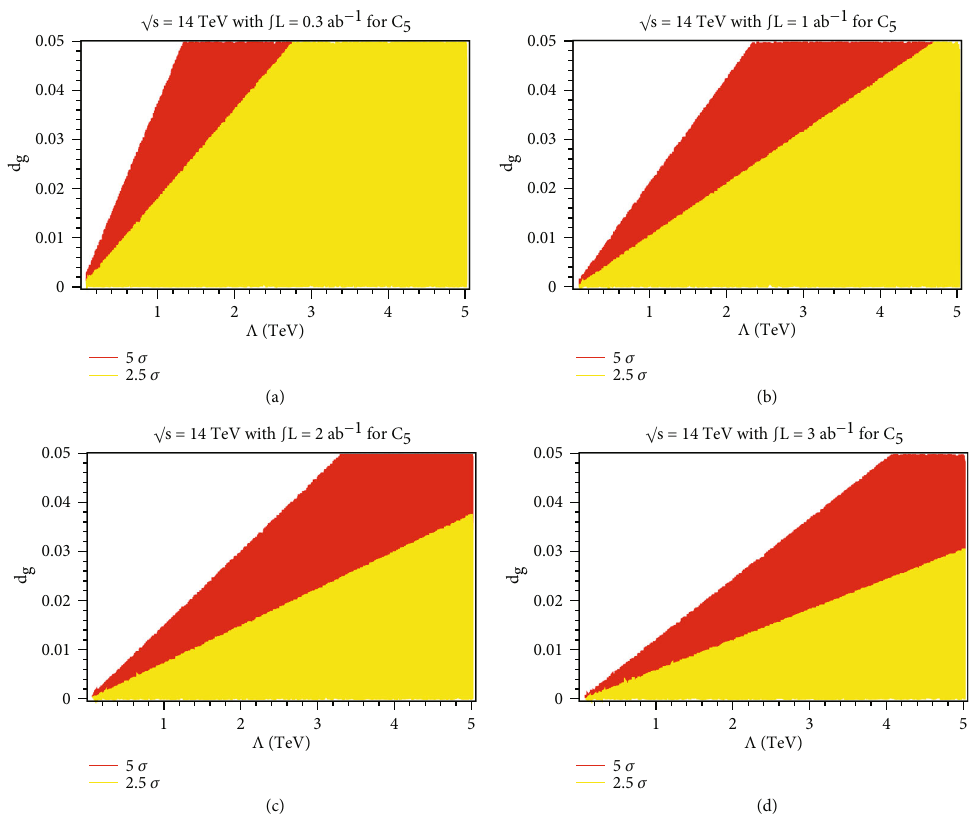
ffiffiffi p at = 14TeV energy at LHC for an integrated luminosity of (a) 0 : 3 ab − 1 , (b) 1 ab − 1 , (c) 2 ab − 1 , and (d) S 5 ffiffiffi p = 13 TeV at LHC for the process pp ⟶ t (cid:1) t ⟶ ð bl + ν S and Λ . The statistical uncertainty at the 1 σ con fi dence level in all the results is estimated to be about g